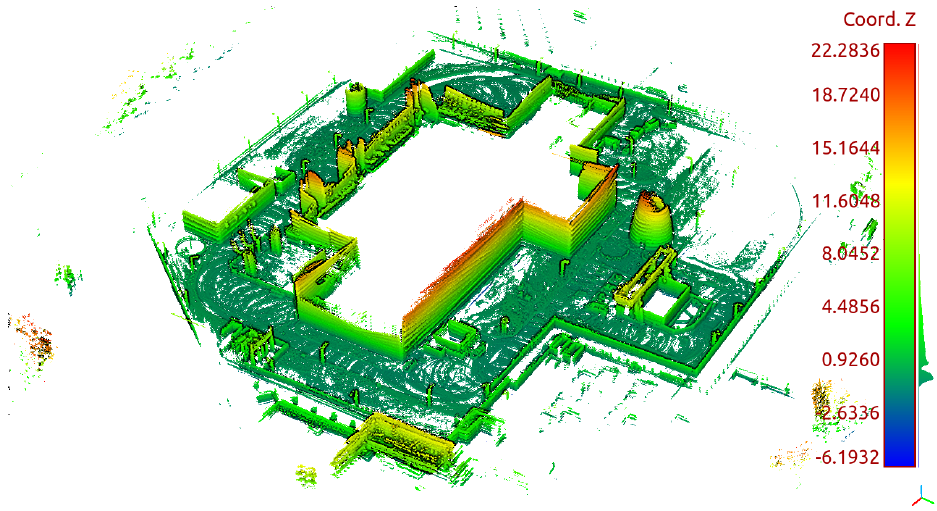
Figure 15. Side view of map of the Zwentendorf NPP obtained with VLP 16.